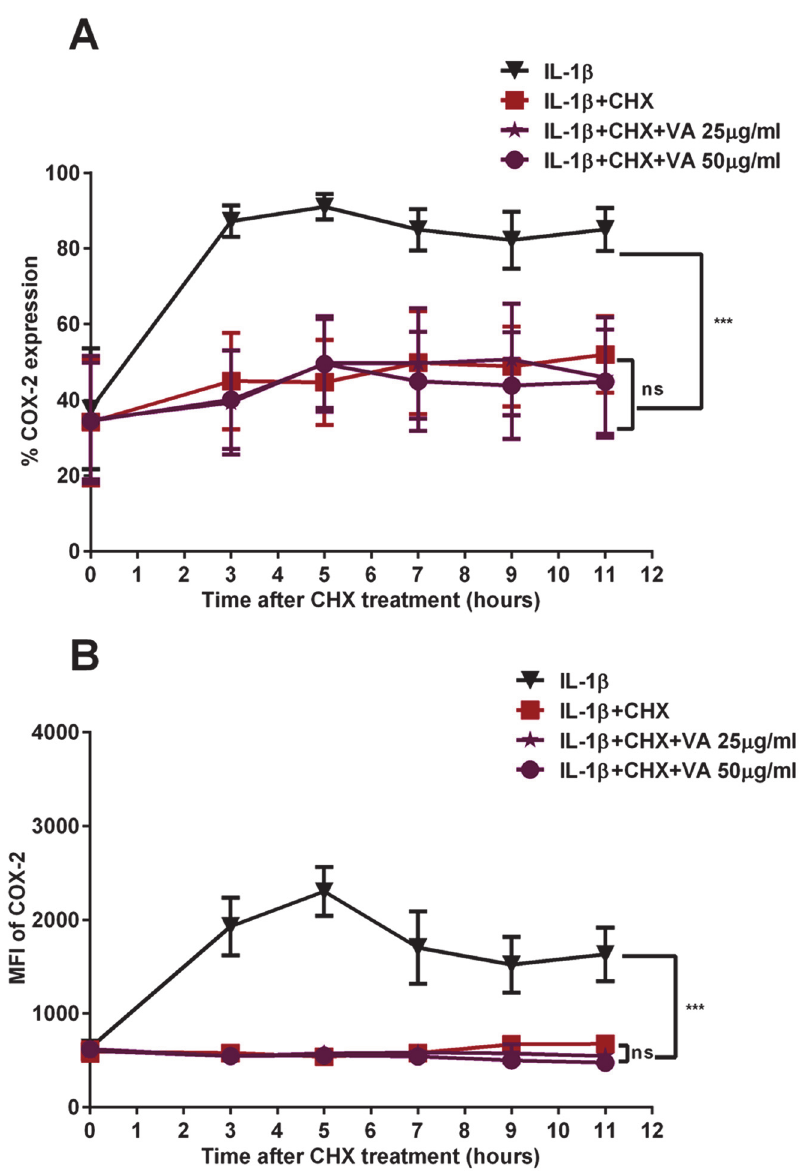
Fig 2. Effect of Viscum album on the stability of COX-2 protein as analyzed by flow cytometry. A549 cells were stimulated with IL-1 β for 90 minutes with or without VA Qu Spez. Cells were harvested at different time intervals after blocking the protein synthesis with cyclohexamide (10 μ g/ml) for 90 minutes till 11 hours. Normalised percentage COX-2 expression as measured in intracellular staining by flow cytometry (A) and mean fluorescence intensity (MFI) of COX-2 expression (B) is shown. Data is representative of mean ± SEM of three independent